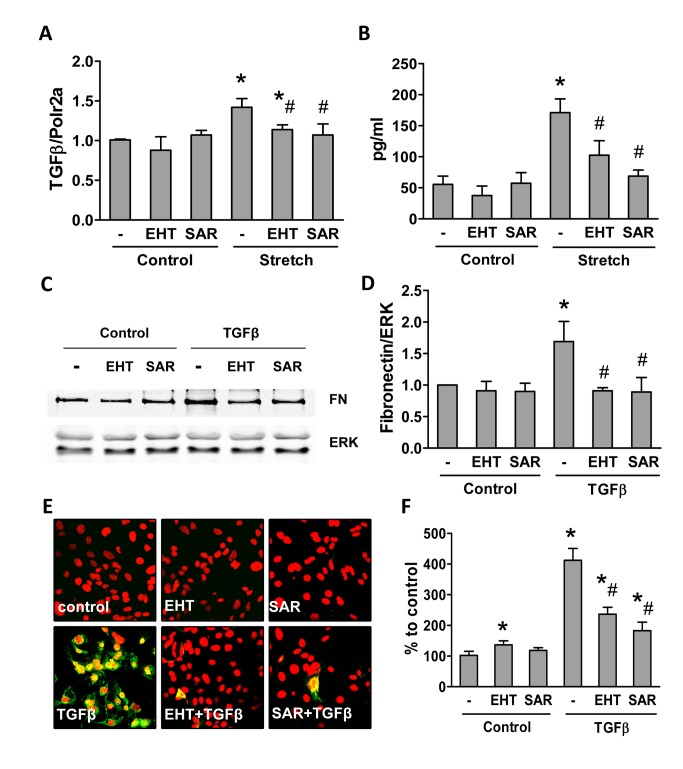
TGFβ-induced podocyte signaling involves small GTPases.RT-PCR for TGFβ (A) in podocytes with and without exposure to stretch (24hours) in the absence or presence EHT (1µM) or SAR (1µM). (B) TGFβ protein expression detected by ELISA in podocytes with and without exposure to stretch (24hours) and treated with or without EHT (1µM) or SAR (1µM). Western blot for fibronectin (FN) (C) and quantification (D) produced by primary podocytes stimulated with or without TGFβ (10 ng/ml), in the absence or presence of EHT (1µM) or SAR (1µM). Annexin V staining after exposure with or without TGFβ (24h) (E) and its quantification (F) in podocytes treated with or without EHT (1µM) or SAR (1µM). Data represent the mean ± SEM of three independent experiments. *P<0.05 vs. corresponding non-stretched control (A, B) or non-stimulated control (D, F); # P<0.05 vs. stretched control (A, B) or TGFβ stimulated control (D, F).